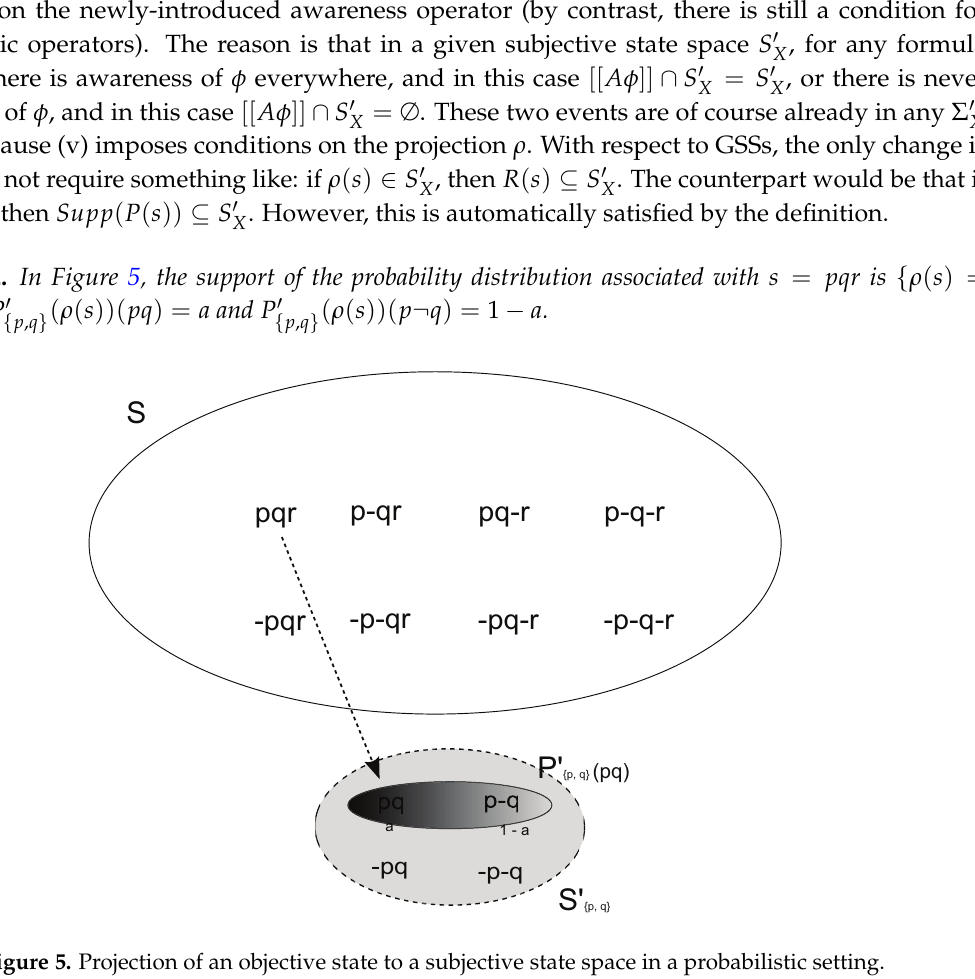
Figure 5. Projection of an objective state to a subjective state space in a probabilistic